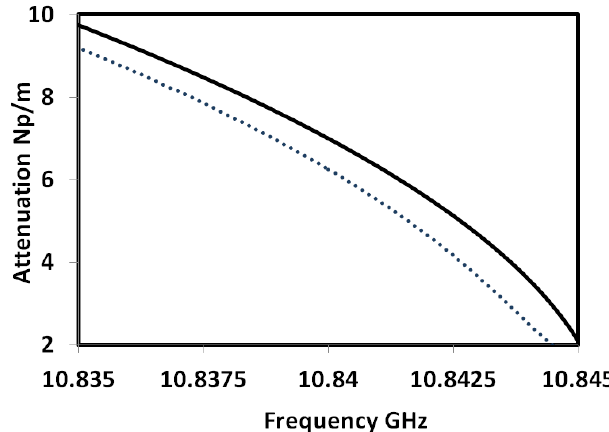
Figure 3: Attenuation of TE11 mode below cutoff in a Nb circular waveguide (with 8.1 mm radius), operating at 4.2 K (solid line) and room temperature (dotted line).